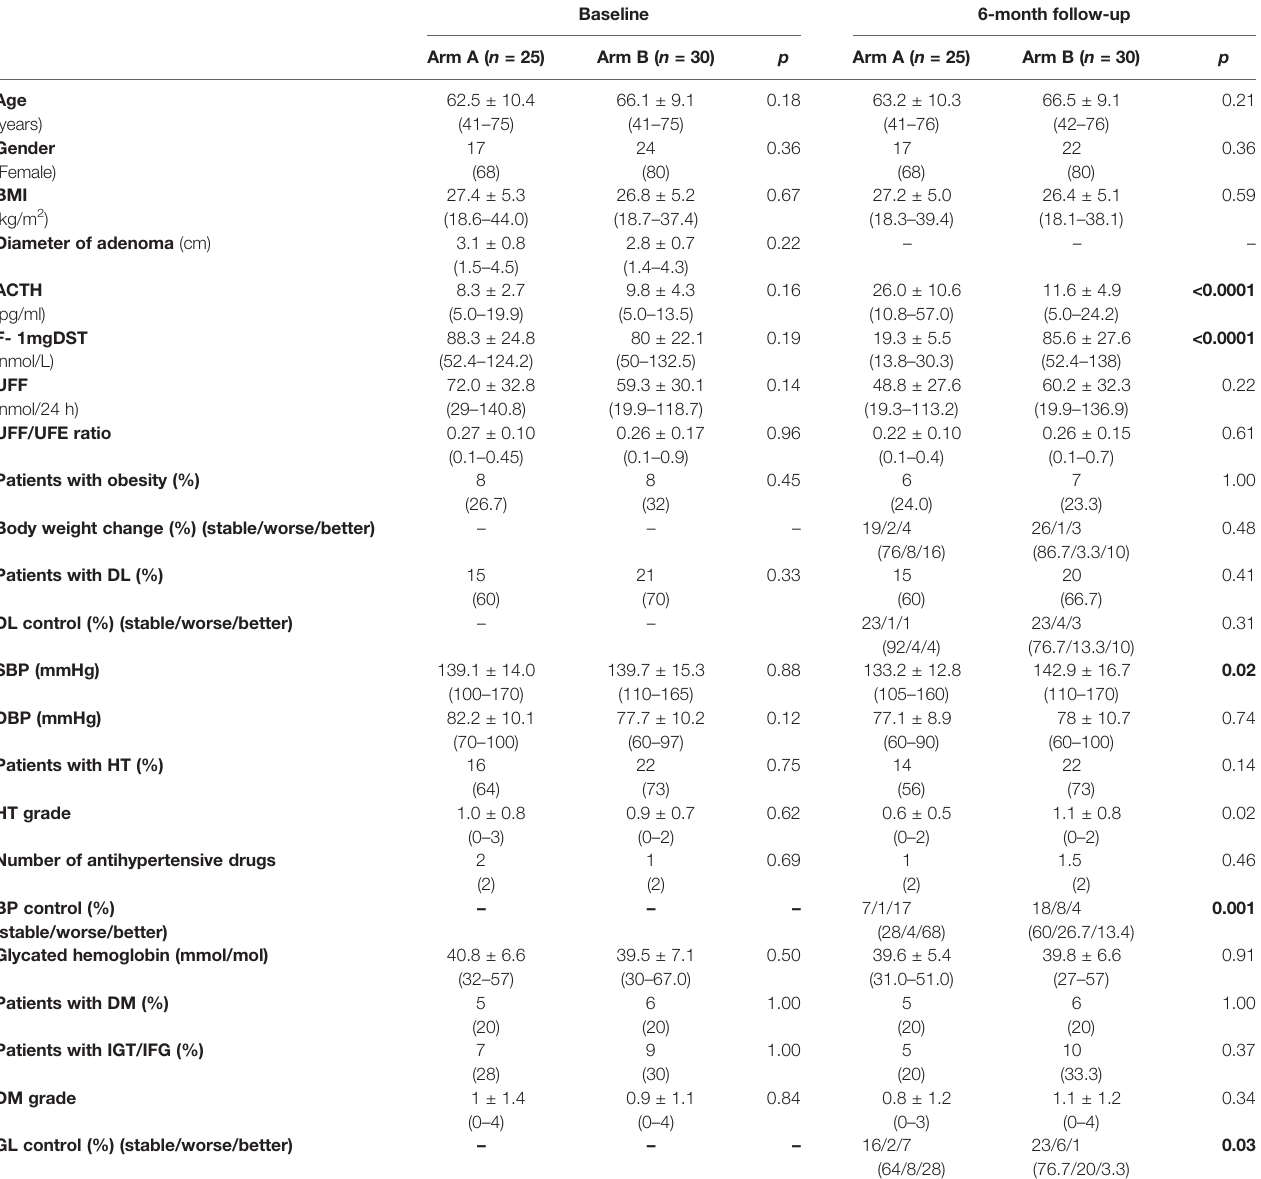
TABLE 2 | Clinical and biochemical modi fi cations in PACS patients conservatively treated and surgically treated and at baseline and at 6 months ’ follow-up.